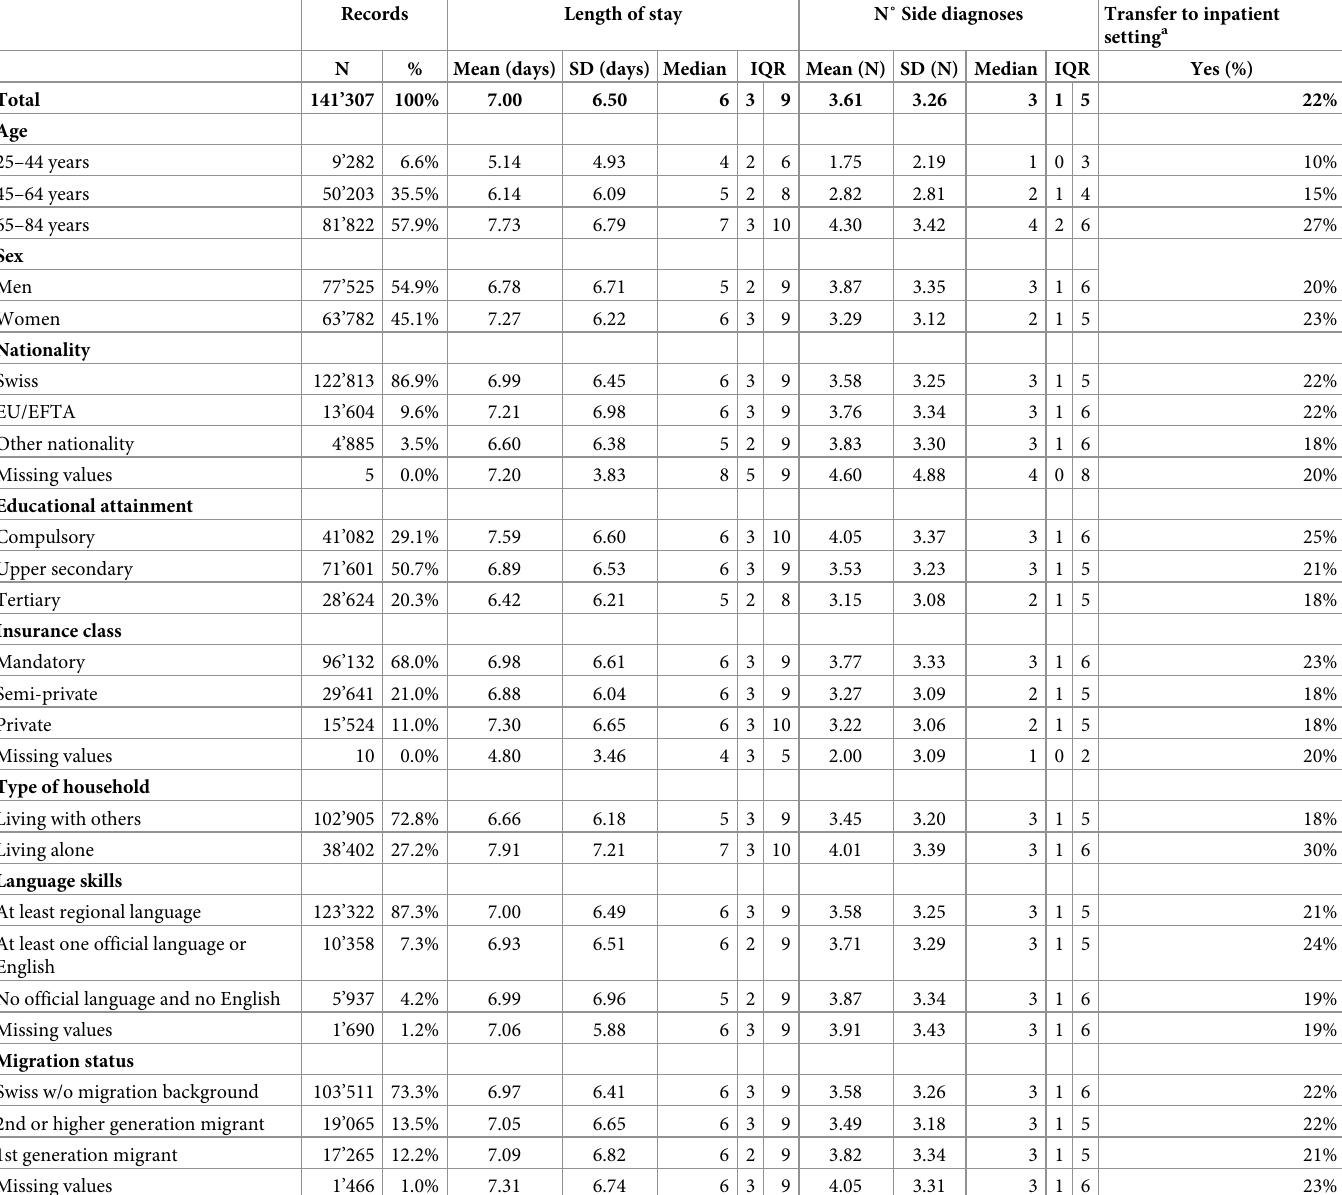
Table 2. Distribution (N records, %) of demographic and social factors with descriptive statistics (mean (SD), median (IQR)) of length of stay and number of side diagnoses and percentage (%) of transfer to inpatient setting =